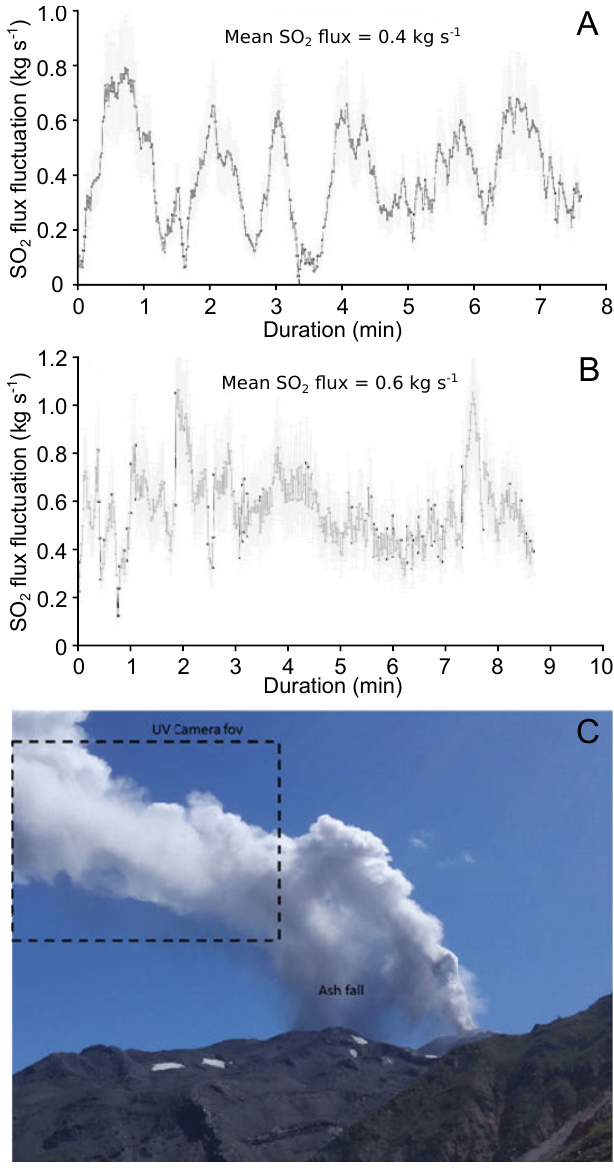
Figure 5: SO flux time series obtained during two pe- 2 riods of eruptive discharge ([A] and [B]) at Nevados de Chillán on 2 February 2016 as measured by UV cam- eras. [C] location of the UV camera field of view, mea- suring SO absorption after most of the ash contained 2 in the plume has separated. The full eruption—which is composed of several pulses—can been seen in the supplementary